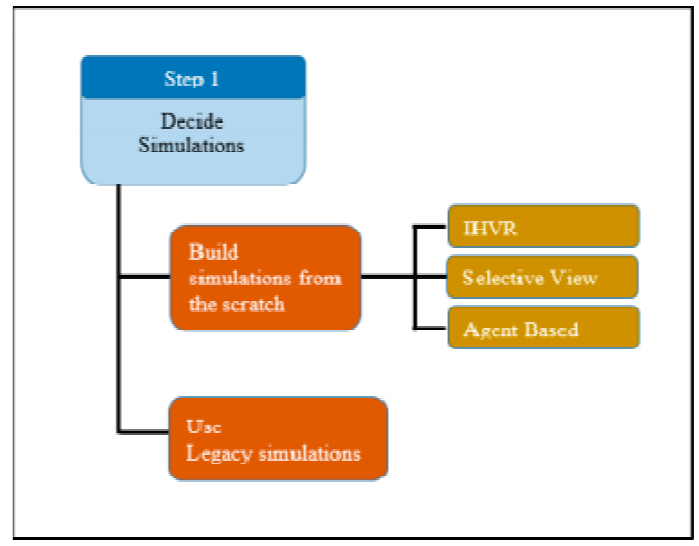
Figure 7. Decide simulations (Step 1).